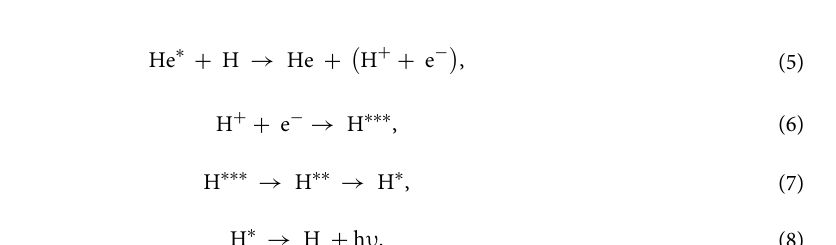
Figure 4. Emission spectra of zircaloy-4 sample containing 800 mg/kg of H. A double-pulse orthogonal configuration was used. The second laser was fired 0.5 μs after the first laser. The surrounding He gas pressure was kept constant at 3 kPa. The gate delay and gate width of the detection system were set as 200 ns and 50 μs, respectively, after the initiation of the second laser. Inset shows the full emission intensity of the H I 656.2 nm